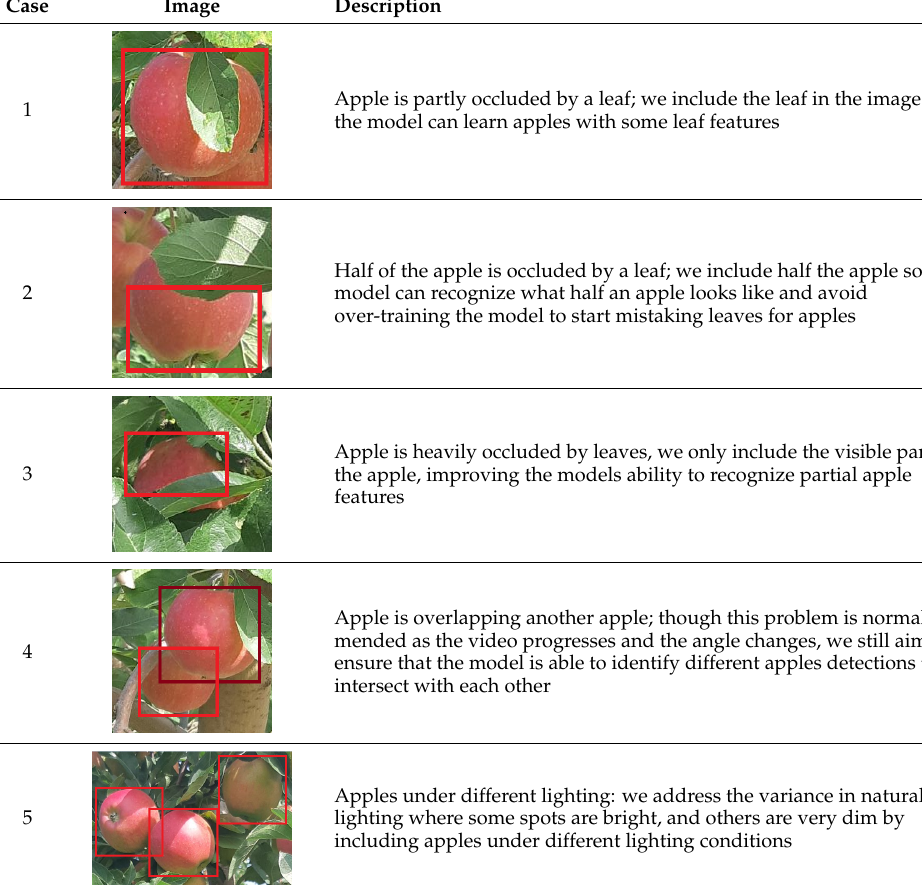
Table 4. Different cases that affect the appearance of an apple that we include in our training